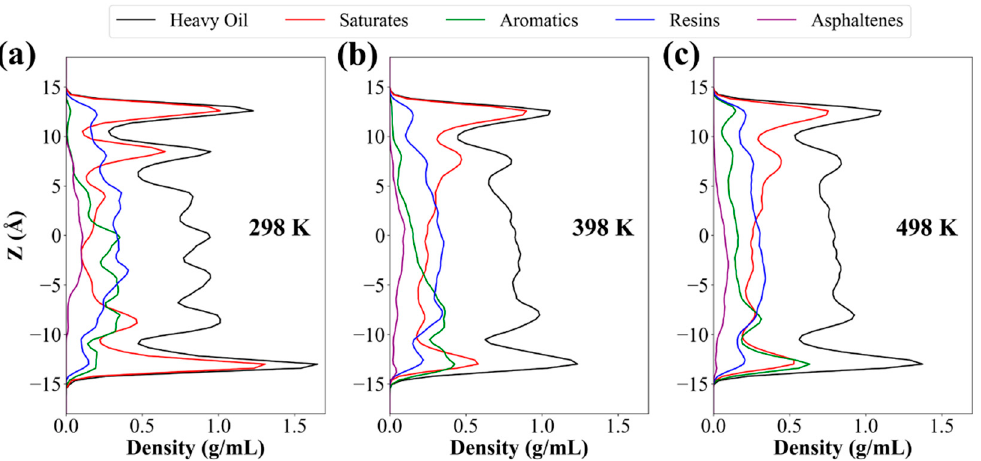
Figure 4. Density profiles of heavy oil and fractions in nanopore at ( a ) 298 K, ( b ) 398 K, and ( c ) 498 K, respectively.